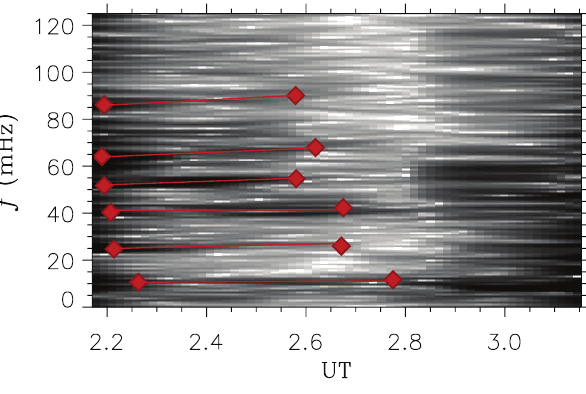
Fig. 3. Plot of power spectrum of the azimuthal component of the magnetic field with red diamonds at the position of mouse clicks and red lines showing the computer generated fits to the wave bands.